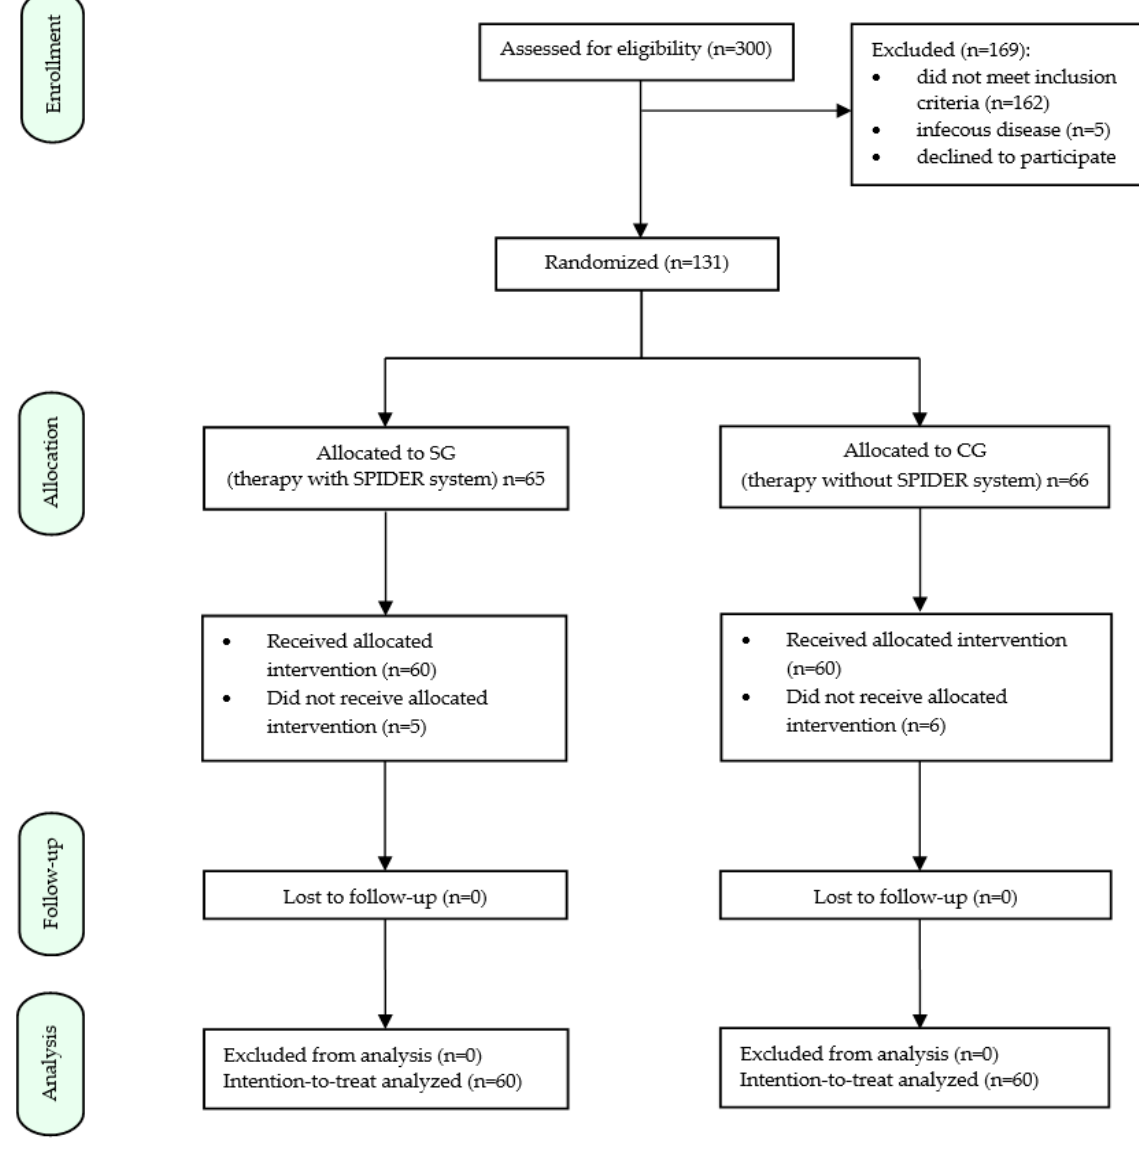
Figure 1. Study design flowchart.